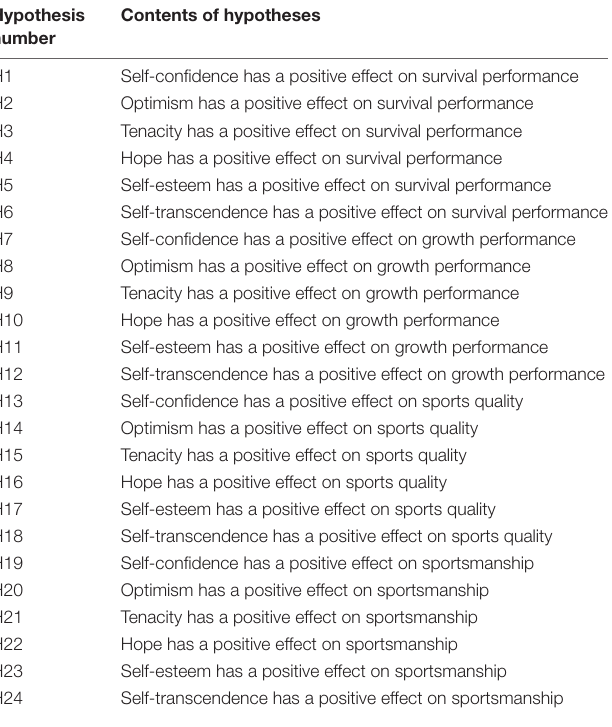
TABLE 1 | 24 Hypotheses about influencing factors of psychological capital (PsyCap) and sports